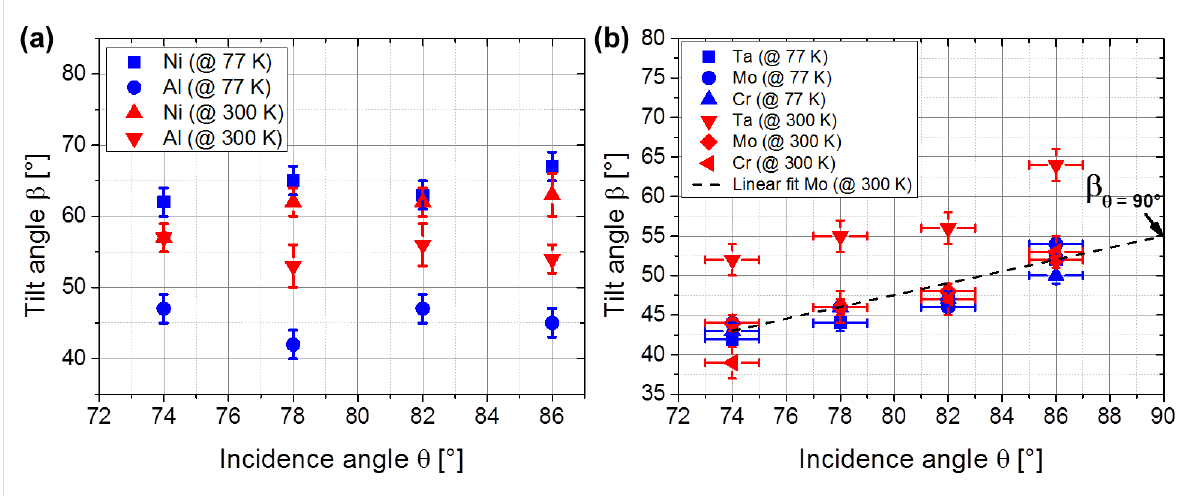
Figure 5: Column tilt angles of (a) low-melting metals Al, Ni and (b) high-melting metals Ta, Mo and Cr deposited at 77 K and 300 K substrate tem- perature and with varying incidence angles.